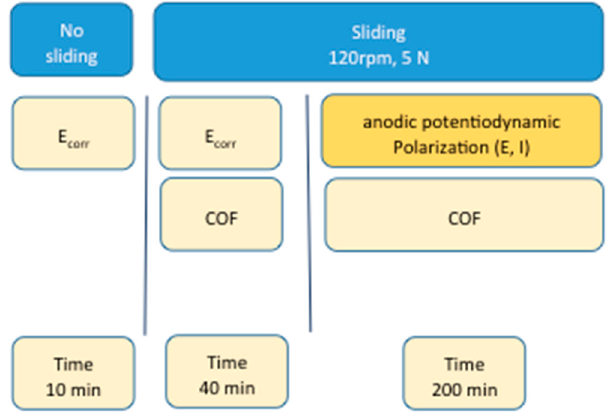
Figure 8. Schema of the experimental procedure of the wear-corrosion tests.